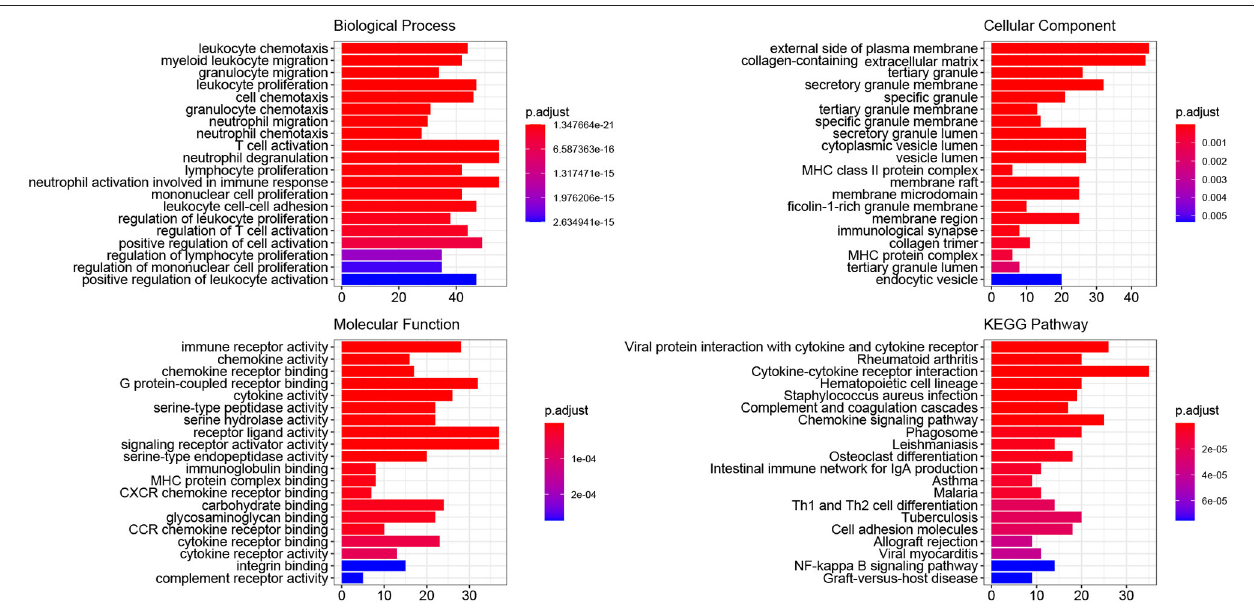
FIGURE 2 | GO and KEGG pathway-enrichment analysis of DEGs. The colors, ranging from blue to red, represent adjusted P -value of each term, whereas the numbers in the X-axis indicate the number of DEGs for each specific term.